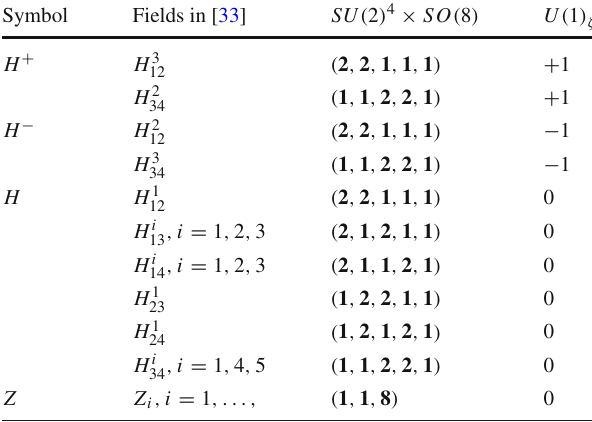
Table 2 Hidden sector field notation and associated states in [33] Symbol Fields in